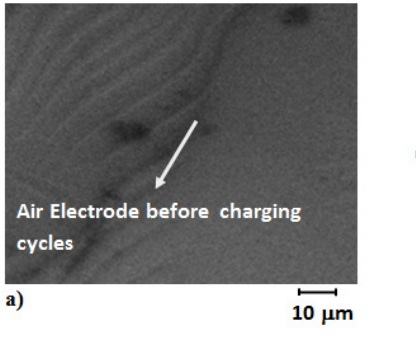
Figure 10. Air electrode micro-graphs by SEM ( a ) before and ( b ) after 17 cycles.